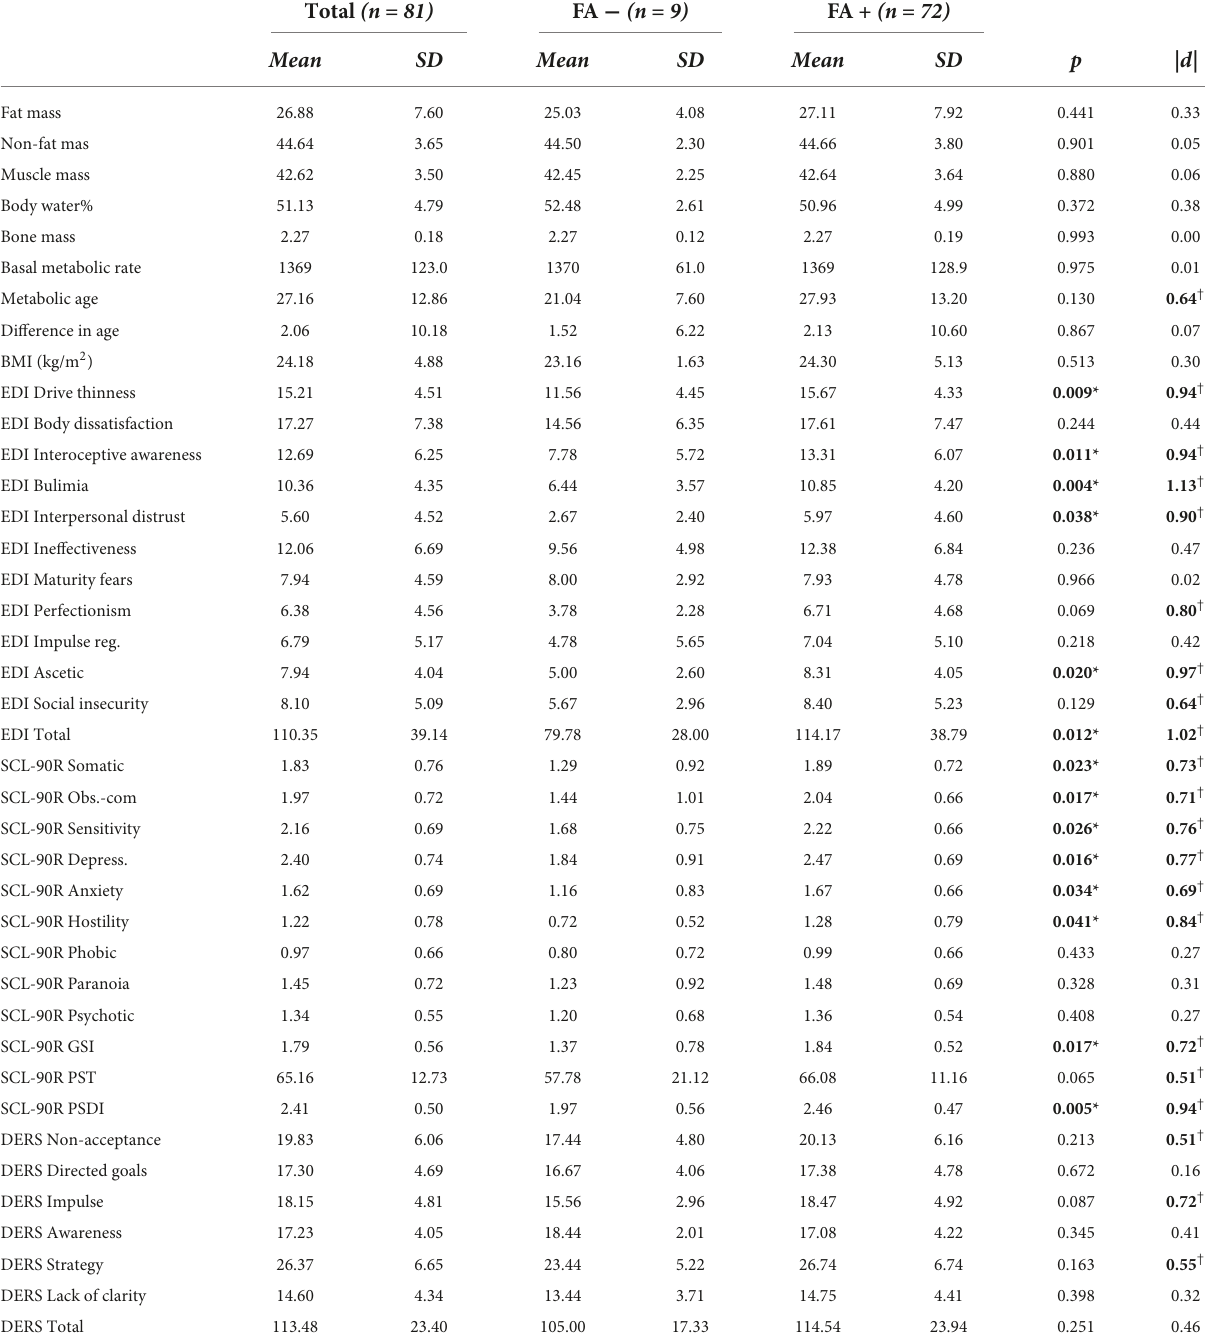
TABLE 2 Association between food addiction (FA) screening scores and clinical